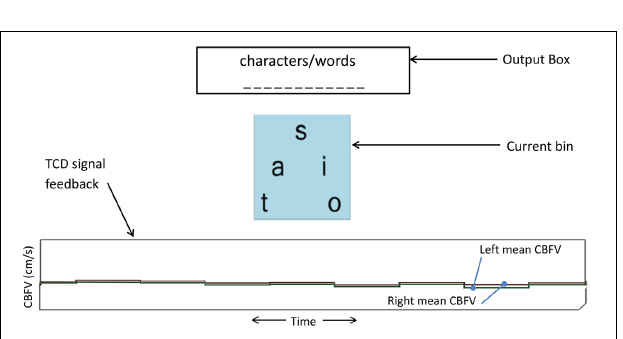
FIGURE 2 | TCD-BCI interface. The bottom graph is the dynamic feedback signal showing a 10-s segment of left and right mean CBFV. Each step of the graph represents an average of 1.3s of CBFV data (sampling rate of 100Hz). This display facilitated the visual tracking task for inducing the rest state.